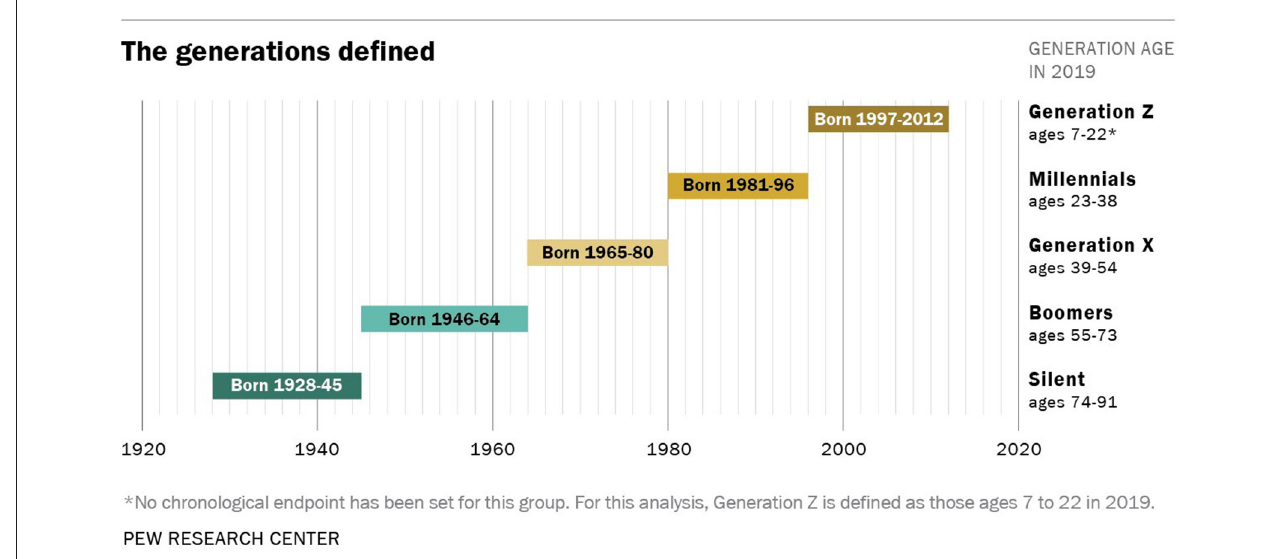
FIGURE 1 | Pew Research’s demographic analysis. Source: Pew Research Center